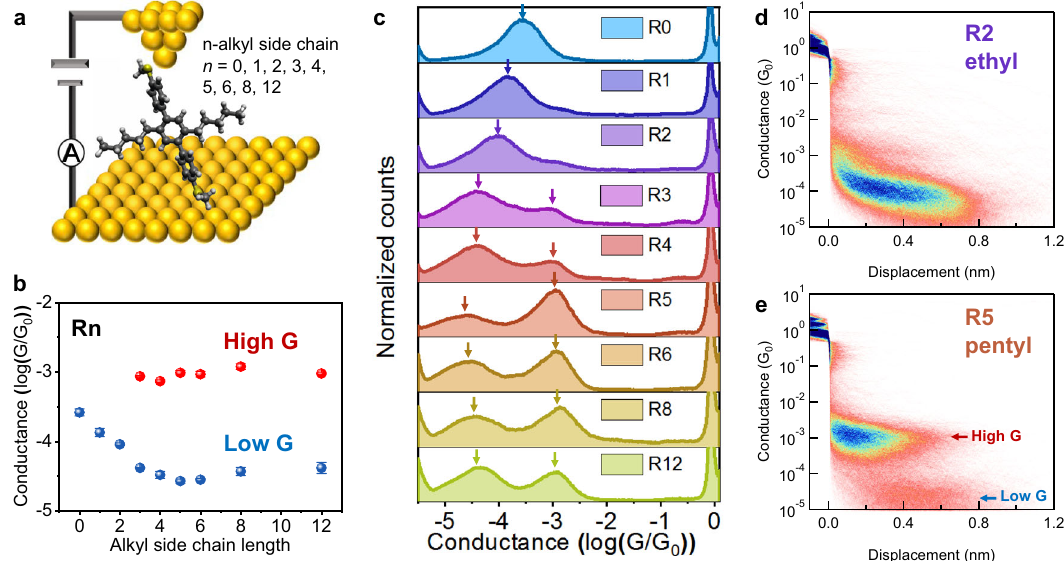
Fig. 2 Single-molecule characterization of charge transport in terphenyl derivatives with different alkyl side chains. a Schematic of Au – Rn – Au junction. b Conductance peak values of 1 mM Rn at 0.25 V applied bias. c 1D conductance histograms for 1 mM Rn at 0.25 V bias voltages, each constructed from >4000 traces. d , e Representative 2D conductance histograms for R2 and R5.